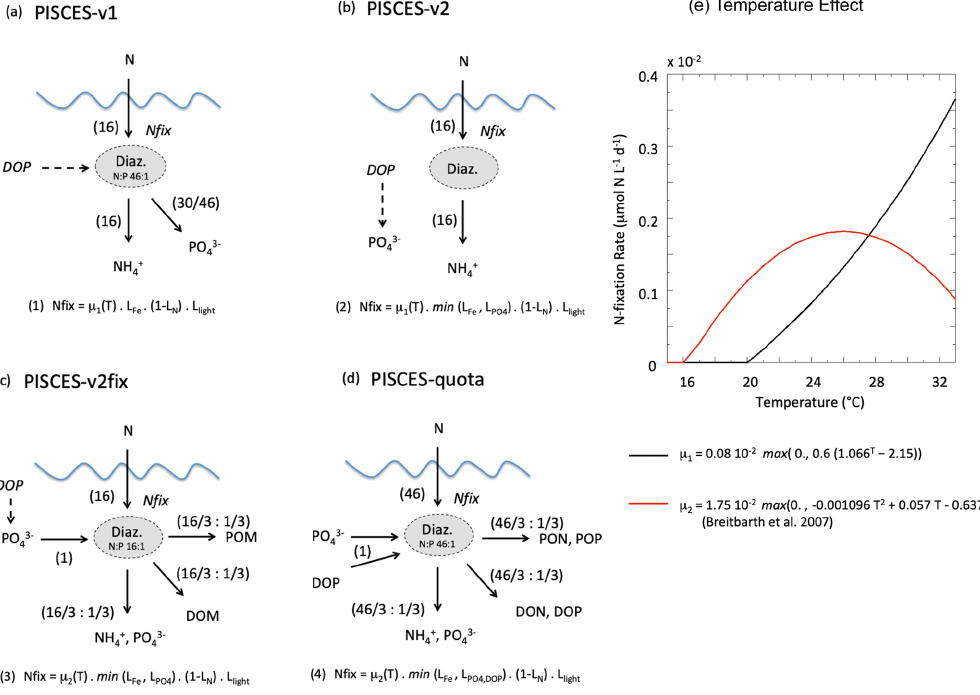
, L Fe and L N limitation terms 4